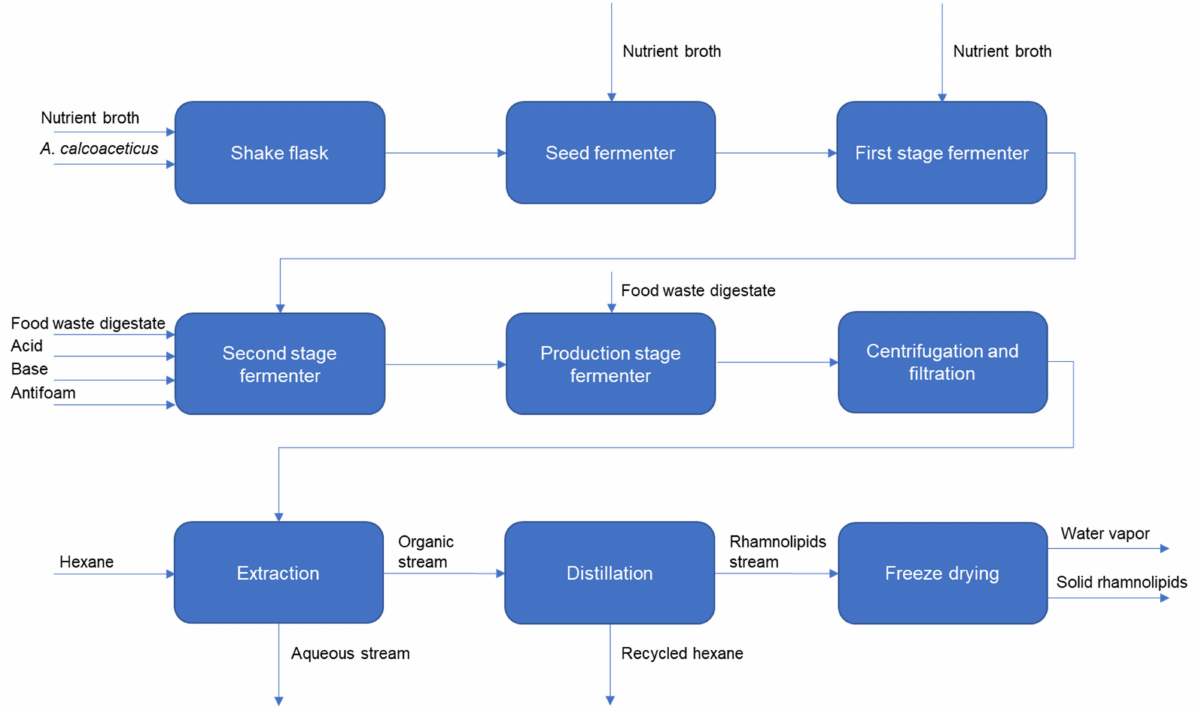
Figure 1. Schematic of steps in the conversion of food waste digestate to